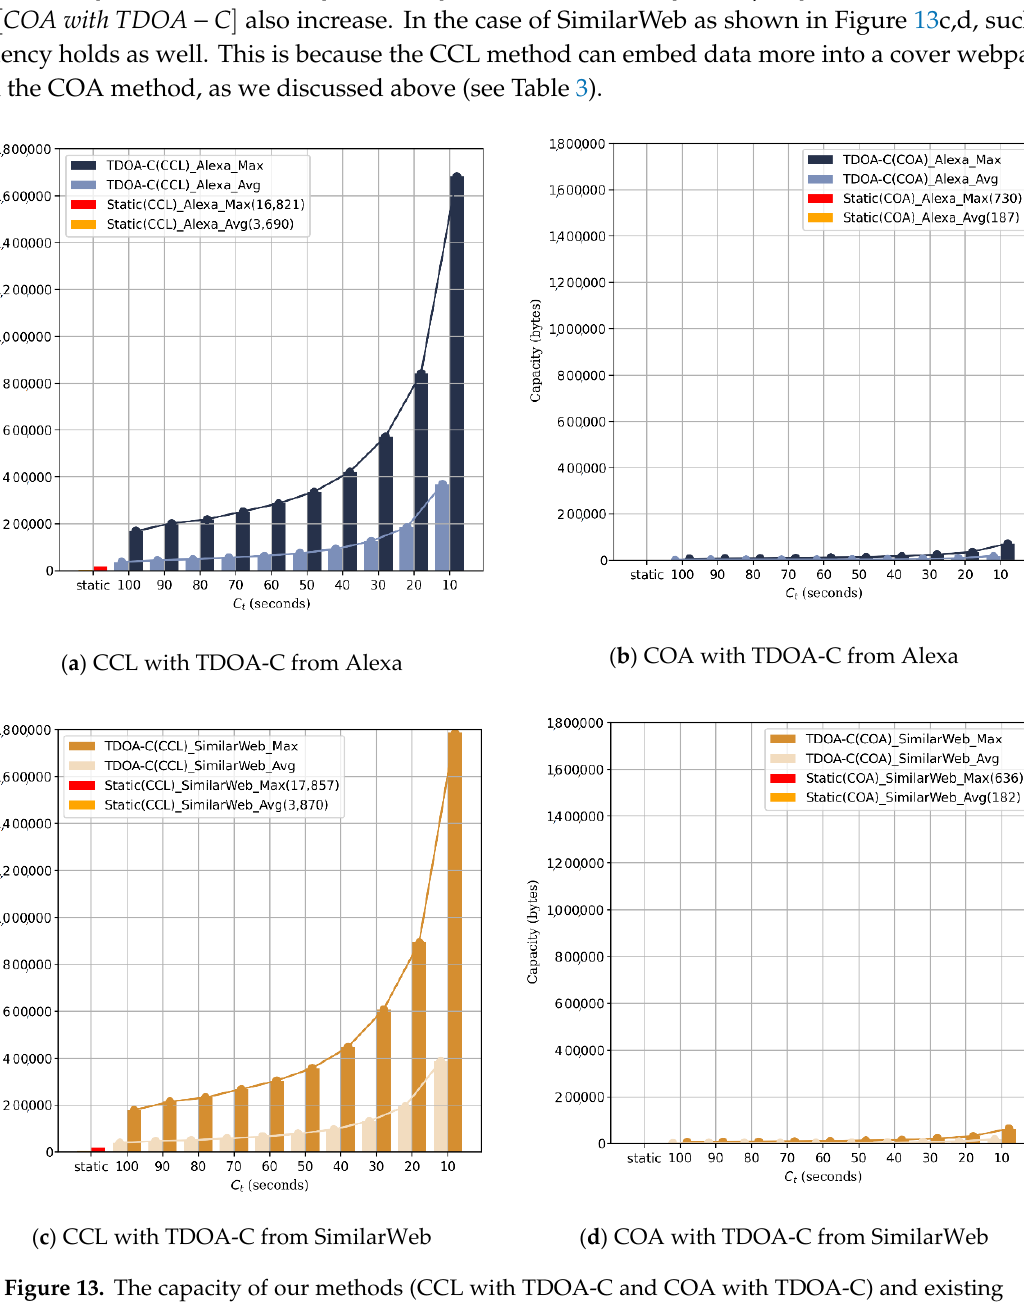
Figure 13. The capacity of our methods (CCL with TDOA-C and COA with TDOA-C) and existing methods (CCL and COA) according to 𝐶 𝑡 .